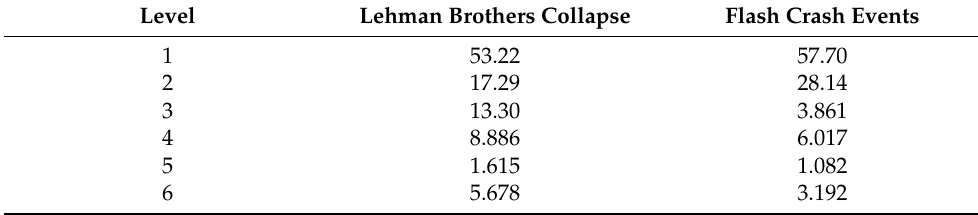
Table 11. Total energy for VZ stock market